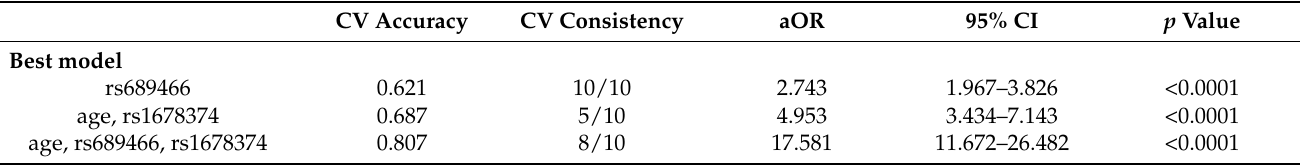
Table 4. MDR analysis for gastric cancer risk prediction, considering the SNPs associated with gastric cancer